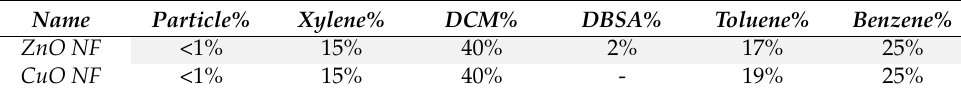
Table 3. Composition of nonfluids in this study.